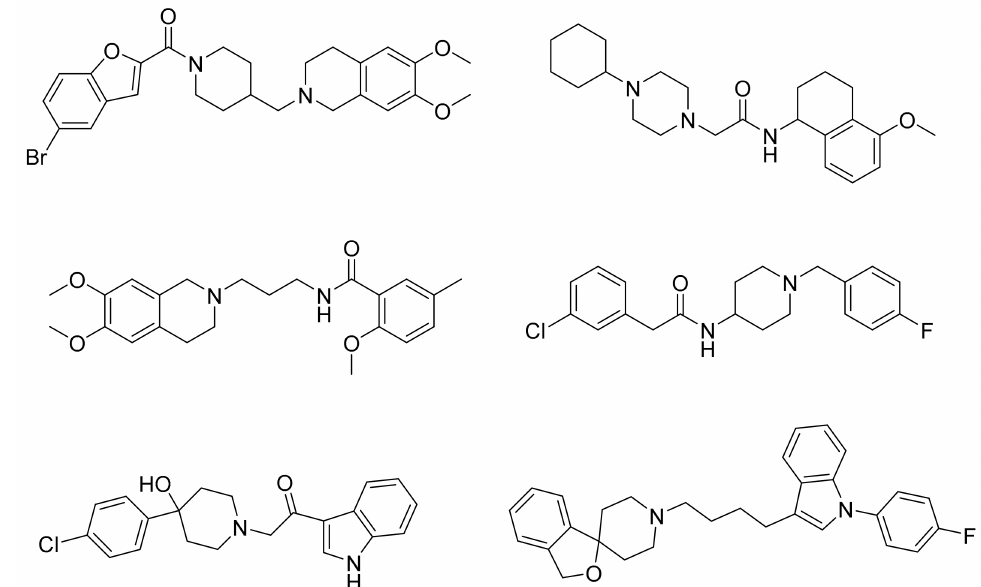
Figure 2. The six structurally diverse S2R ligands that were employed to construct the pharmacophore